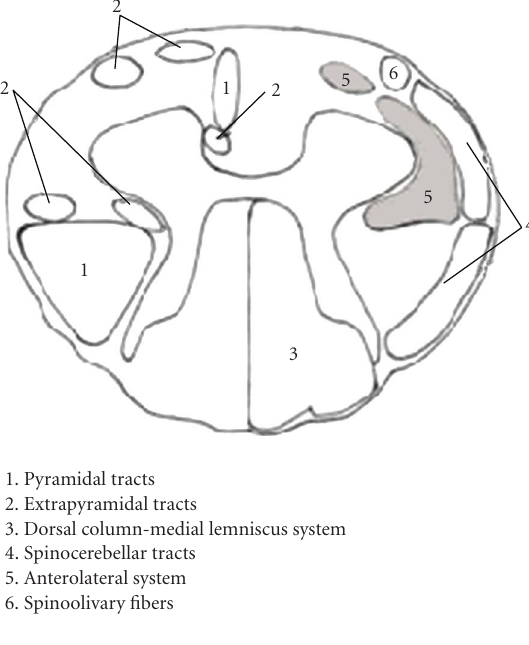
Figure 3: Spinal cord anatomy. The anterior spinothalamic tracts are hypothesized to be the target of IMRT-caused LS and are highlighted in